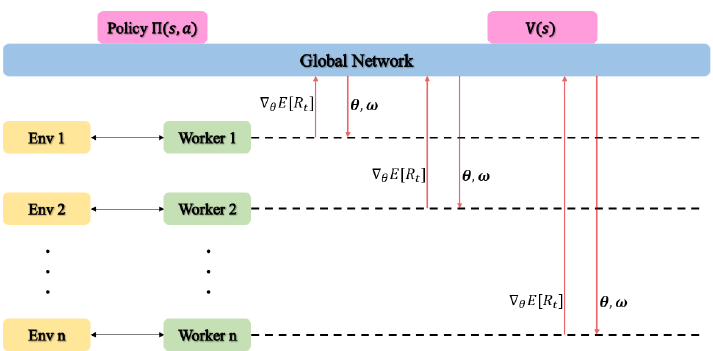
Figure 4. Update principle of A3C